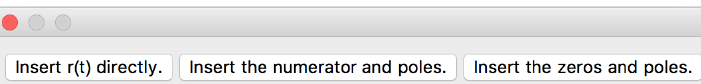
Figure 47. Box with three options to insert the rational function r .